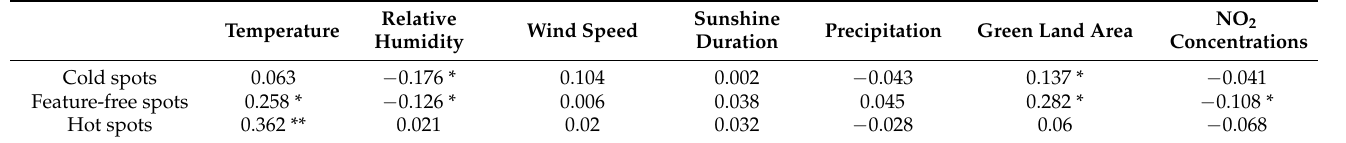
Table 2. Geographical detection analysis of all influencing factors in the cold and hot